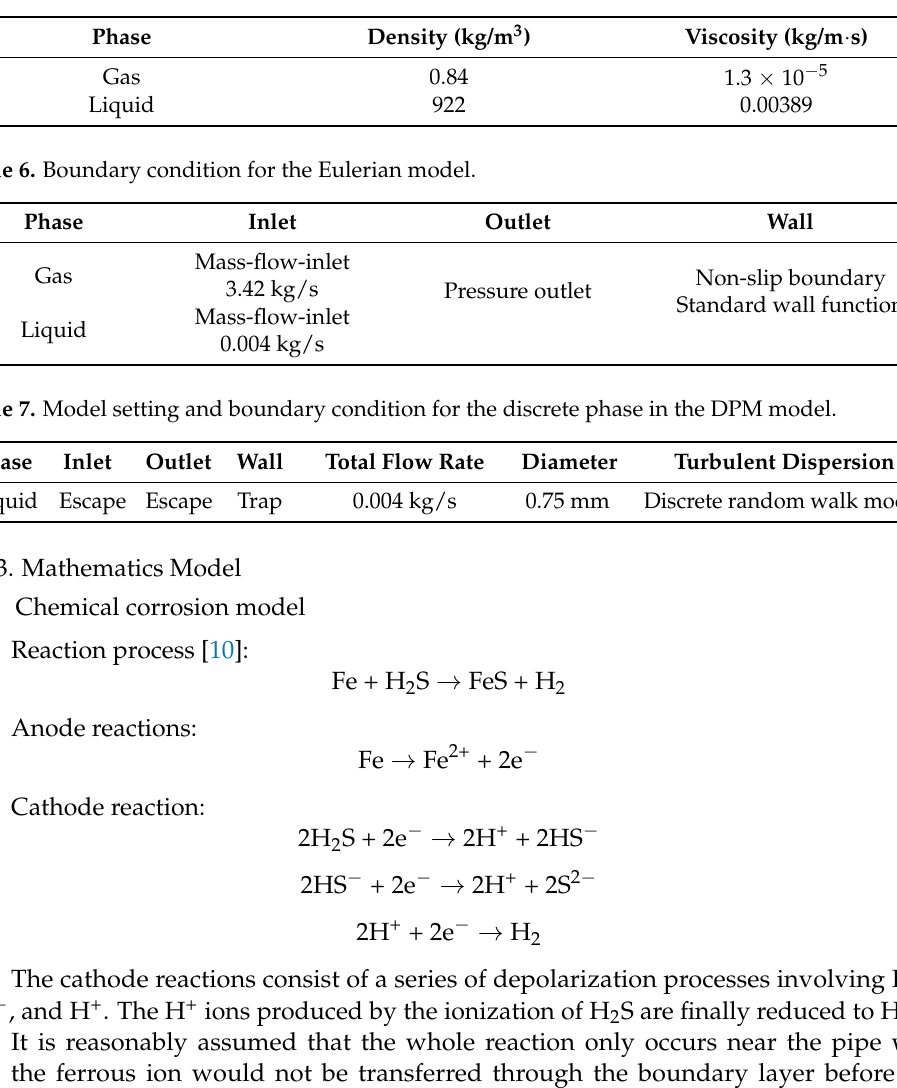
Table 5. The properties of the gas and liquid.